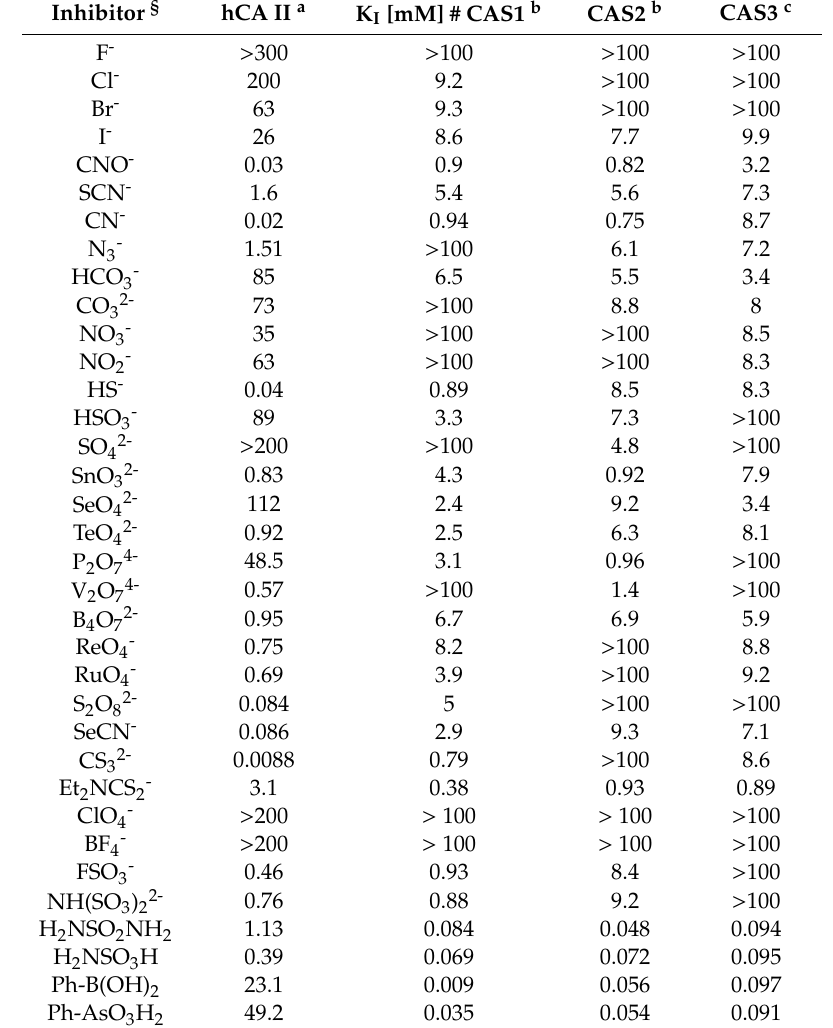
Table 2. Inhibition constants of anionic inhibitors against α -CA isozymes of human origin (hCA II), and the three β -CAs from Sordaria macrospora, CAS1, CAS2 and CAS3, at 20 ◦ C by a stopped flow CO 2 hydrase assay